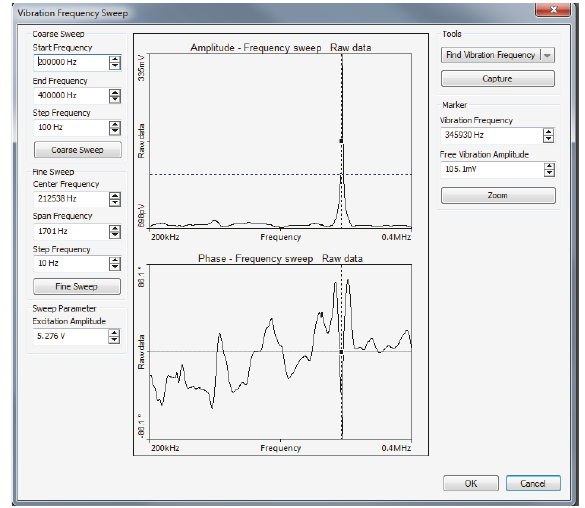
Figure 9: This figure shows the Vibration Frequency Search Dia- logue for the Nanosurf EasyScan 2 software using the DD-ACTA probe. The frequency range was set between 200 and 400 kHz, with the peak frequency occurring at 346